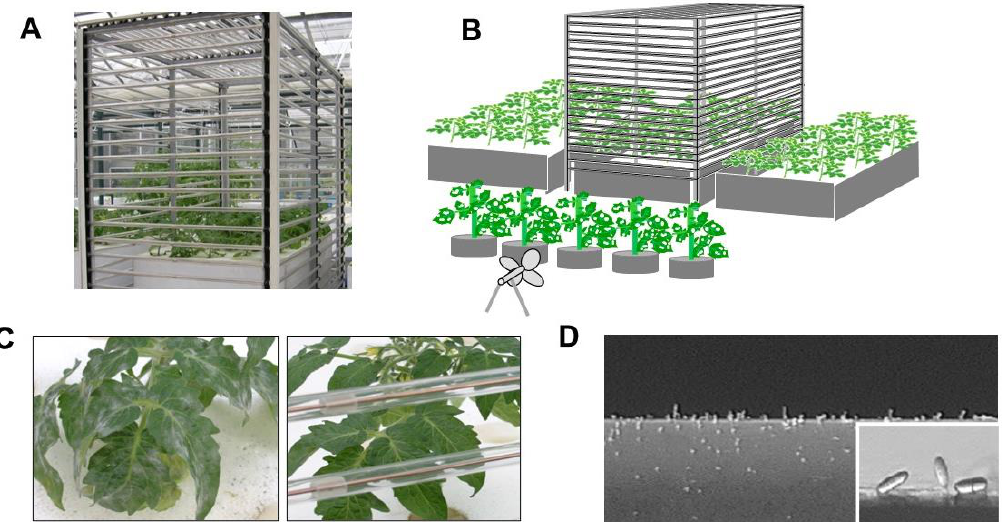
Figure 5. ( A ) Rectangular box furnished with single-charged monopolar electric field screens to cover a hydroponic trough for culturing plant seedlings: ( B ) schematic representation of a method for inoculating powdery mildew pathogen conidia into tomato seedlings in screen-guarded and unguarded hydroponic troughs; ( C ) heavily infected tomato seedlings in the unguarded hydroponic trough (left) and healthy non-infected tomato seedlings in the screen-guarded hydroponic trough (right) at 1 month after inoculation; and ( D ) digital micrographs of conidia captured by the insulated conductor wire of the electric field screen box used to cover the hydroponic trough.